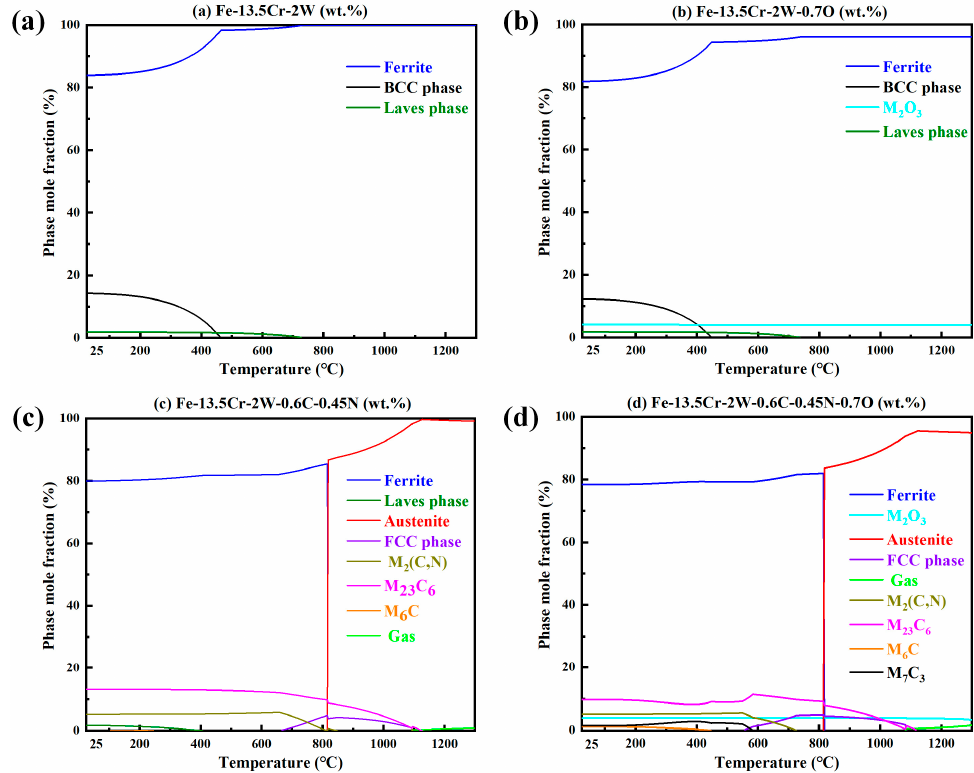
Figure 17. Equilibrium phase compositions of steels with different compositions at different tem- peratures, calculated with Thermo Calc software: ( a ) Fe–13.5Cr–2W, ( b ) Fe–13.5Cr–2W–0.7O, ( c ) Fe–13.5Cr–2W–0.6C–0.45N, and ( d ) Fe–13.5Cr–2W–0.6C–0.45N–0.7O.